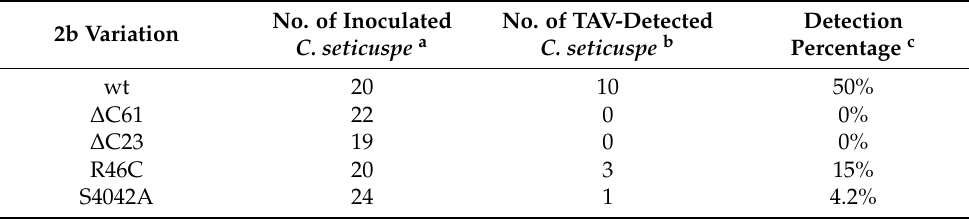
Table 2. Infection of tomato aspermy virus (TAV) 2b mutants in Chrysanthemum seticuspe . No. of Inoculated 2b Variation C. seticuspe